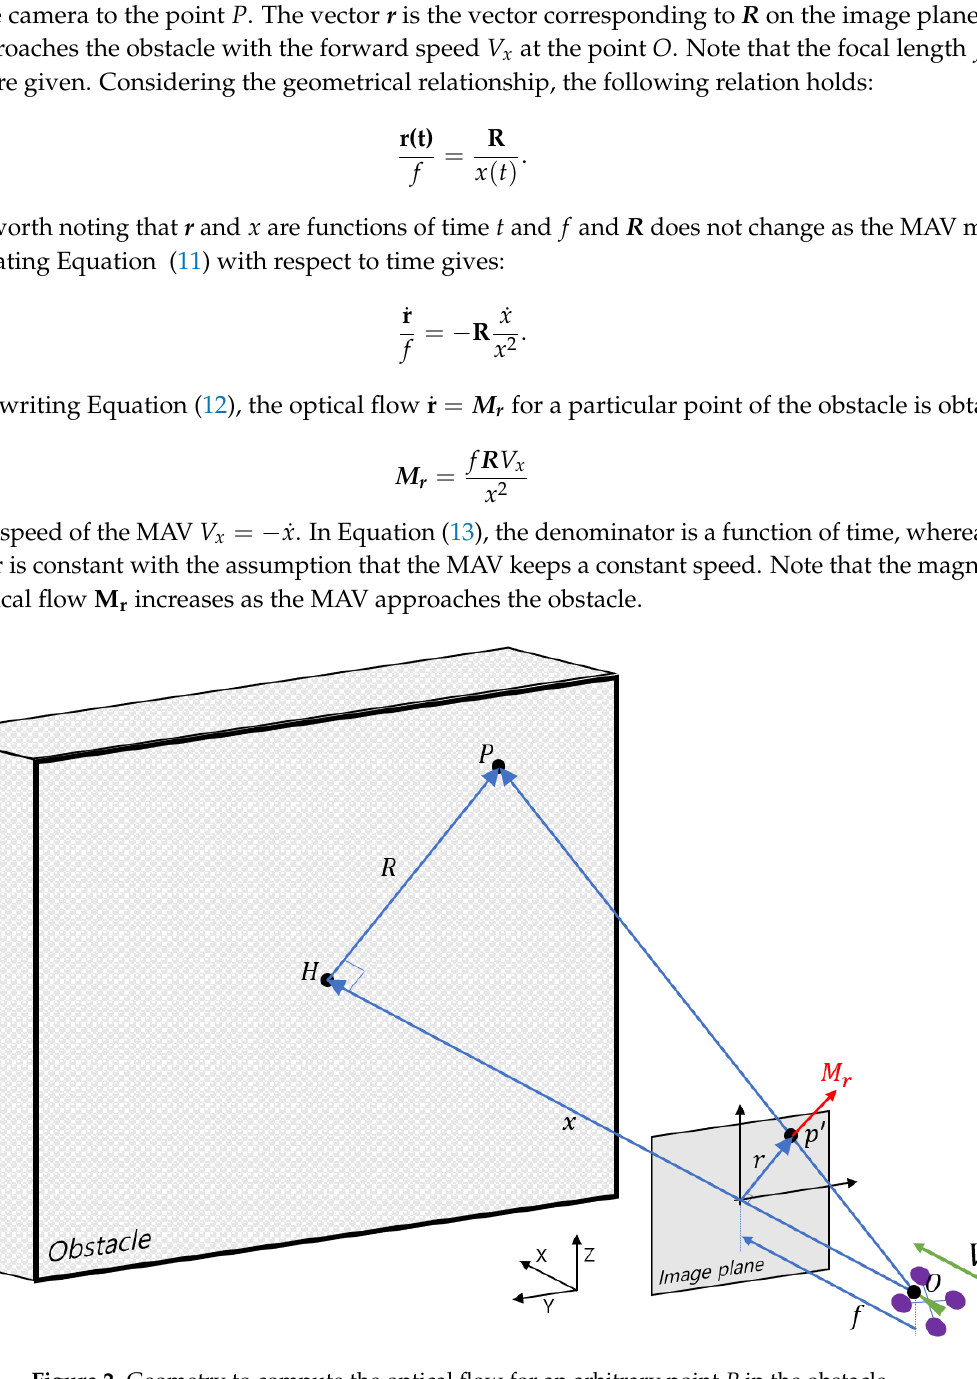
Figure 2. Geometry to compute the optical flow for an arbitrary point P in the